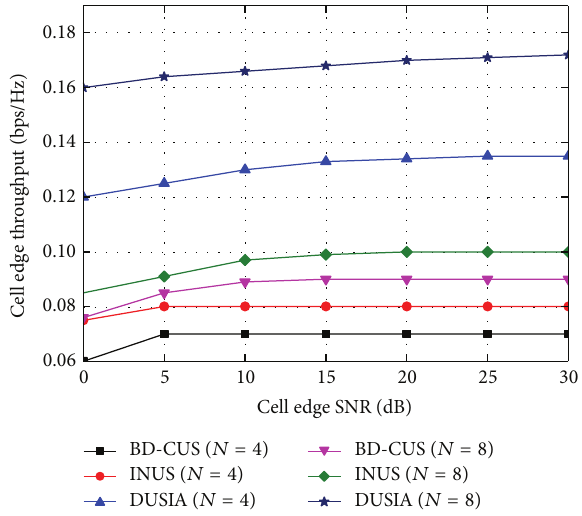
other cell users, so the 5% CDF of SINR of DUSIA is larger than that of INUS. For example, with 𝜉 = 1 , DUSIA improves the 5% CDF of SINR of INUS from −12 dB to −7 dB.